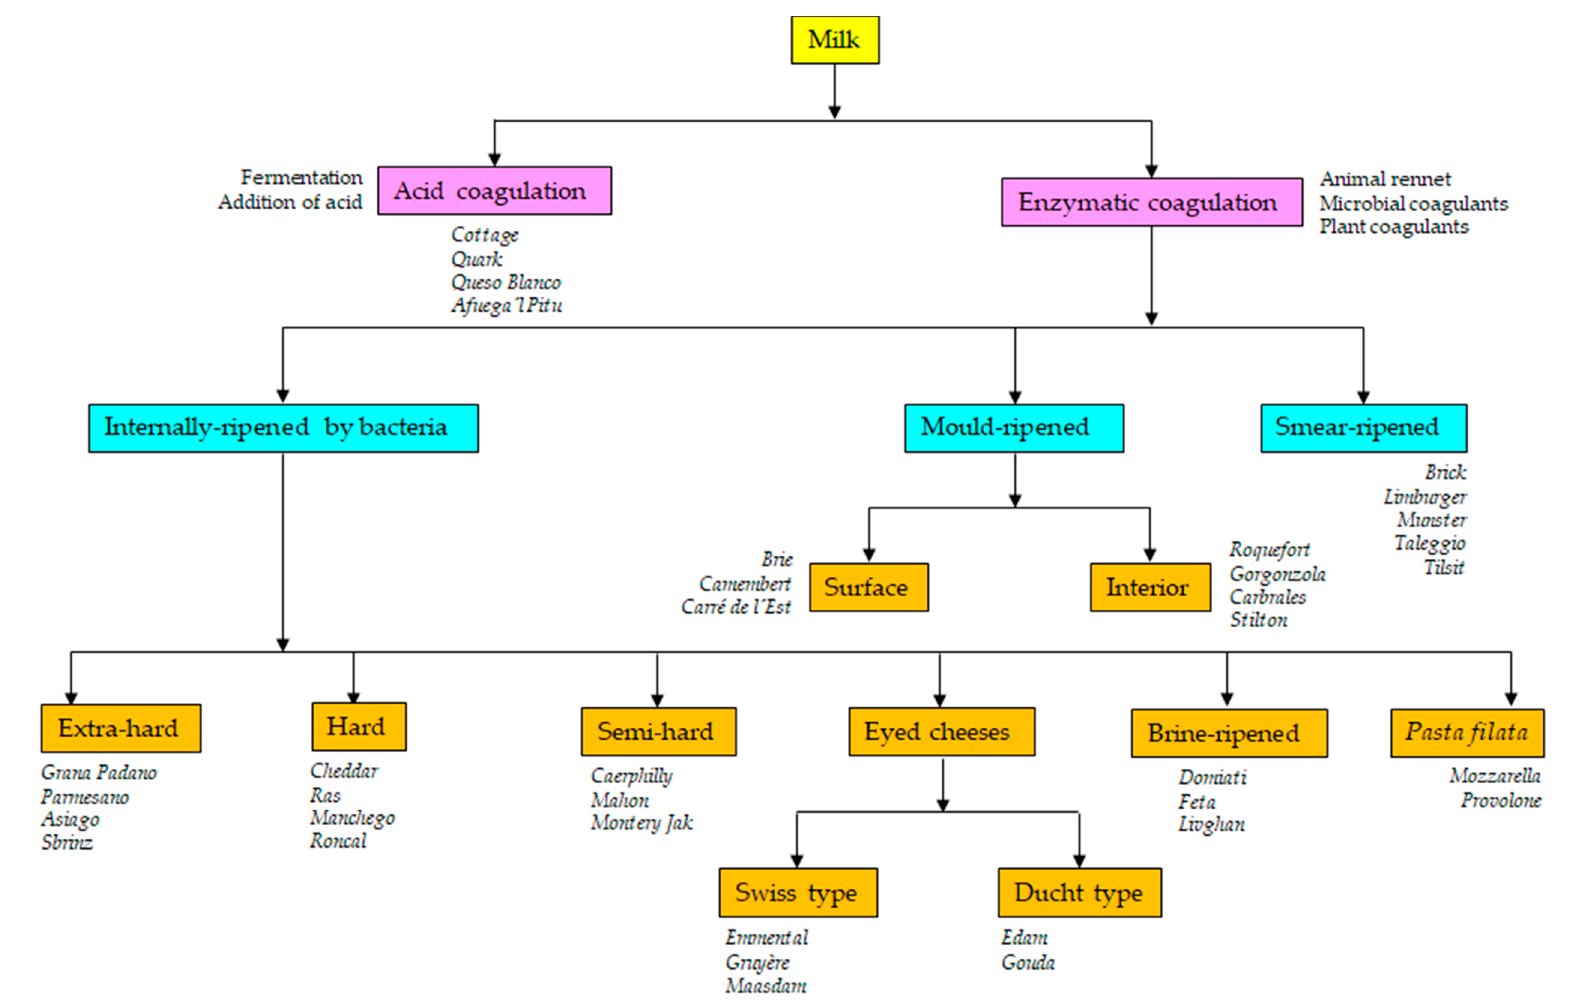
Figure 1. Schematic diagram of the cheese manufacturing processes and types of the resulting cheese varieties.